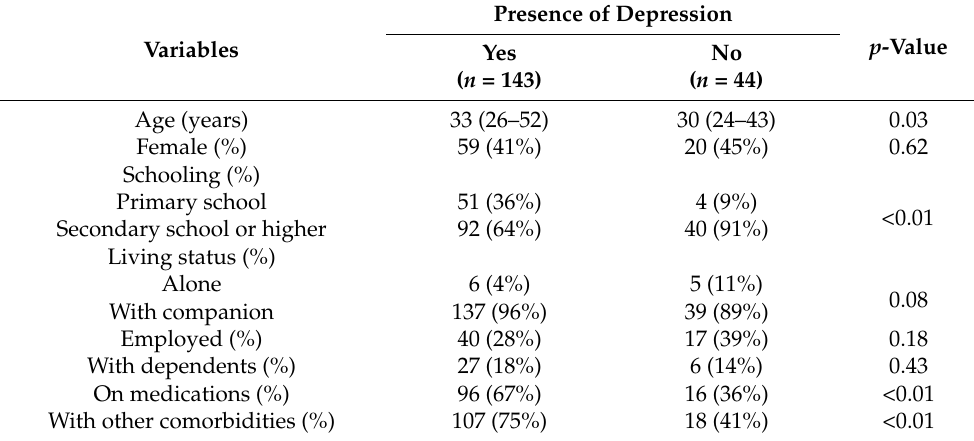
Table 1. Socio-demographic, clinical characteristics, and psychological variables of patients with and without depression (total BDI score ≥ 10 points). Data is shown as median (percentile 25–percentile 75) or absolute value